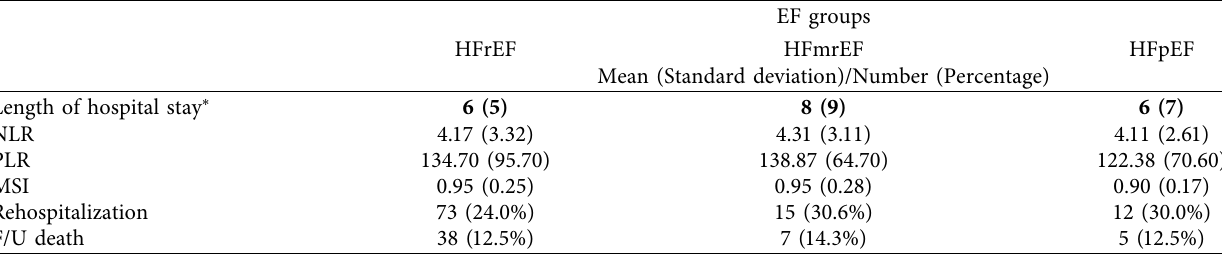
Bold values indicate values with signifcant diferences among HF sub-types. Table 6: Mean ± SD of neutrophil to lymphocyte ratio (NLR), platelets to lymphocyte ratio (PLR), modifed shock index (MSI), and red cell